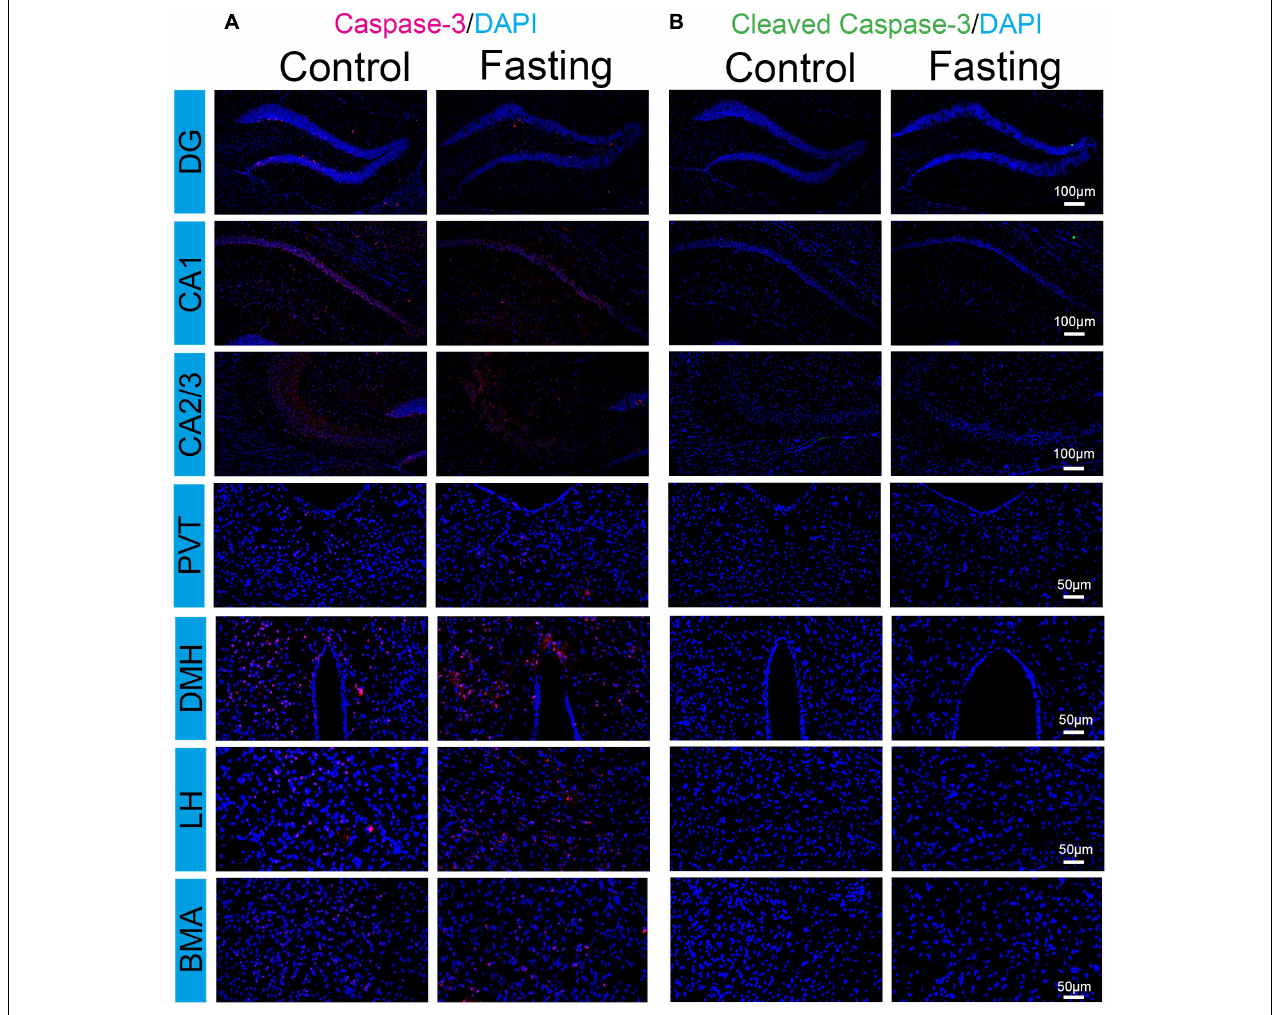
FIGURE 7 | Acute fasting does not induce cell apoptosis in sub-hippocampal and sub-cortical areas. Representative photomicrographs of caspace-3 (A) and cleaved caspace-3 (B) immunostaining in the sub-region of the hippocampus and cortex including DG, CA1 and CA2/3, PVT, DMH, LH, and BMA. No cleaved caspase-3 immunoreactivity was detected in both control and fasting group. Scale bars, 100 µ m (DG, CA1, and CA2/3), 50 µ m (PVT, DMH, LH, and